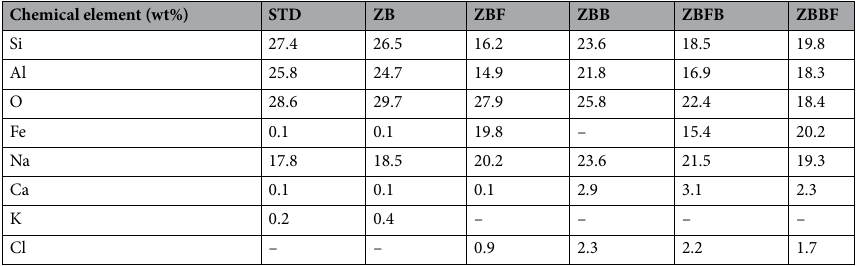
Chemical element (wt%)